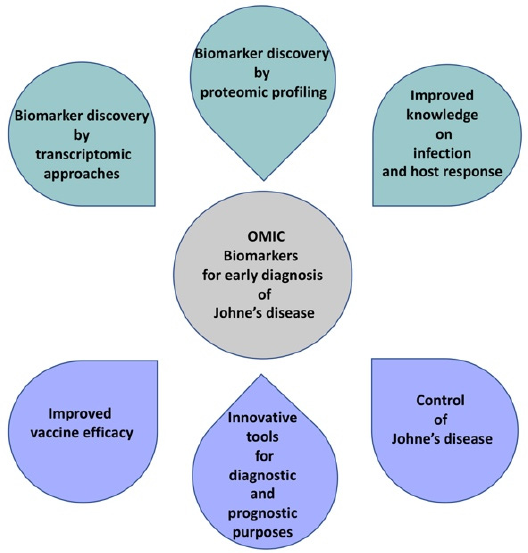
Figure 1. Tools used to identify “omics” biomarkers for early detection of Johne’s disease and their possible applications for disease control.